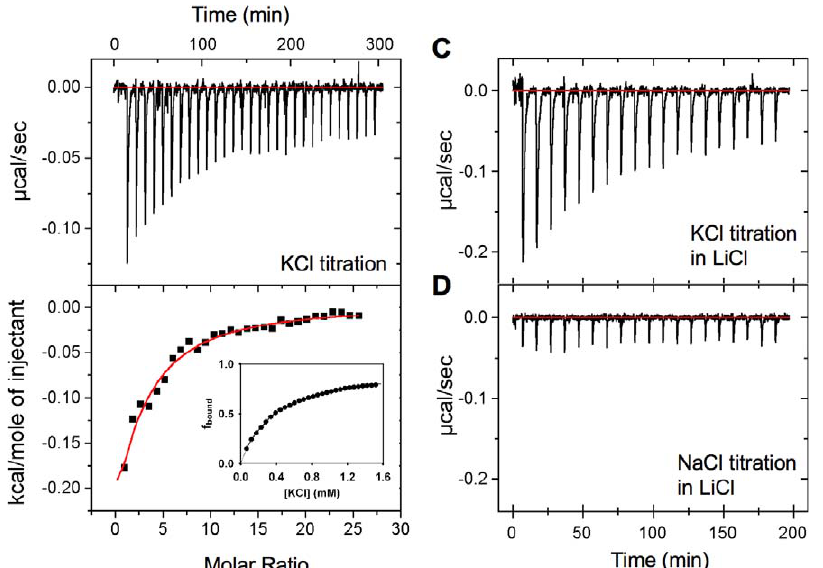
Figure 2. ITC Titration of Alkali Metal Cations Binding to KcsA (A) A KCl solution is titrated into a solution containing KcsA. Each downward deflection corresponds to one injection. The area represents the heat exchanged. (B) The total heat exchanged during each injection is fit to a single-site binding isotherm with K D and D H 8 as independent parameters, where K D ¼ 0.41 mM and D H 8 ¼(cid:2) 1.4 kcal/mol. Similar values for K D and D H 8 are obtained using different protein concentrations varied over a 5-fold range. The inset shows the same data represented as the fraction of ion-bound KcsA as a function of [KCl]. (C) A KCl solution titrated into KcsA in a background solution of LiCl instead of NaCl (as is used in Figure 2A) shows heat from ion binding. (D) A NaCl solution titrated into KcsA in the background of LiCl shows only the heat of diluting NaCl without binding to KcsA.